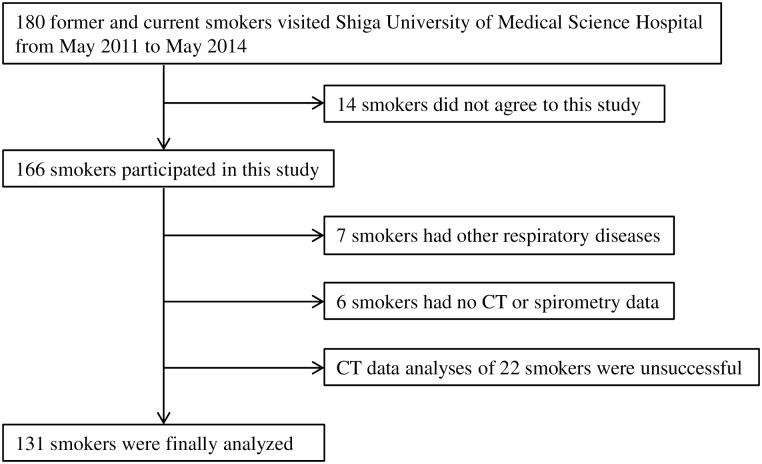
Disposition of Subjects.